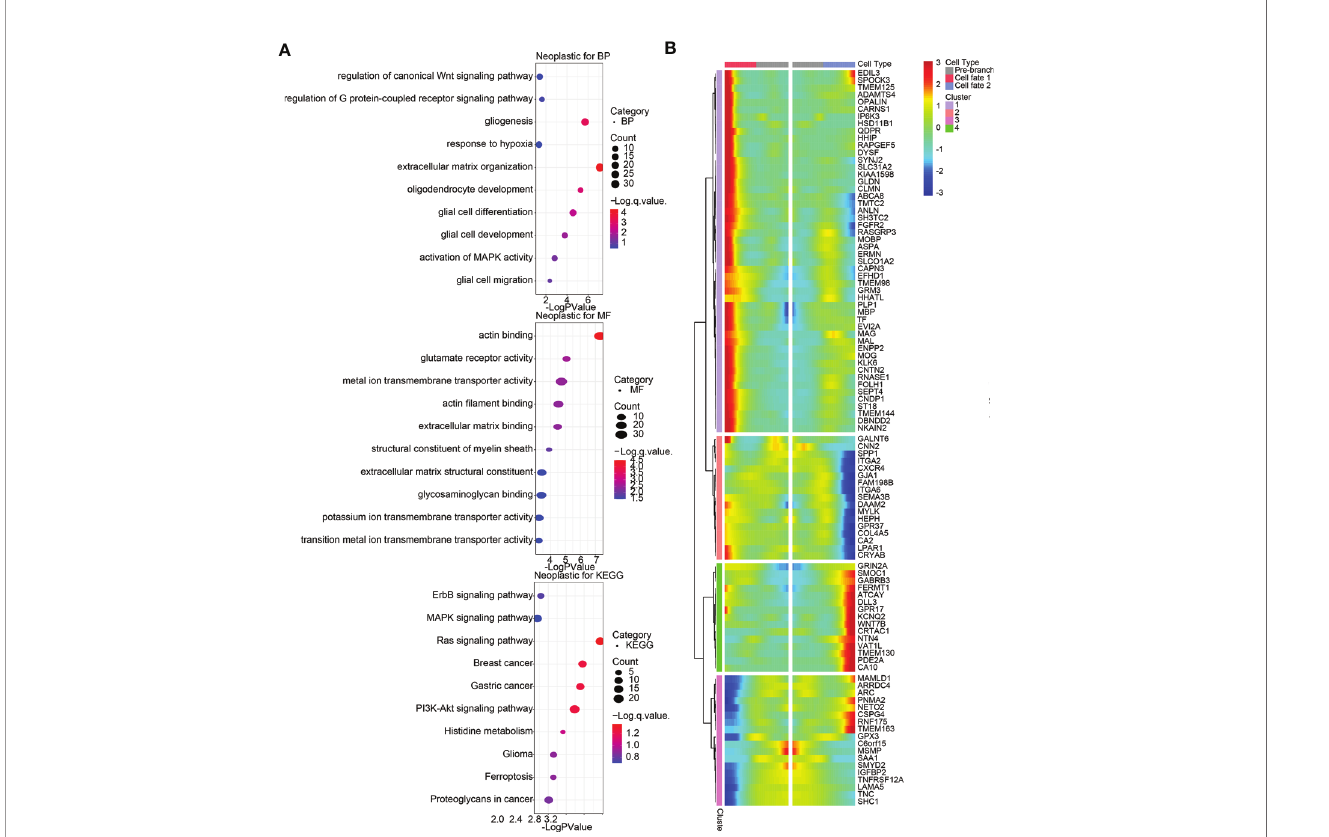
FIGURE 6 | Differentially expressed genes (DEGs) and functional annotations of glioma neoplastic cells in single-cell pseudotime trajectories. (A) Biological processes (BP) and molecular functions (MF) from Gene Oncology (GO) enrichment analysis and Kyoto Encyclopedia of Genes and Genomes (KEGG) pathway analysis based on DEGs for branch point 2 in neoplastic cells. (B) Heatmap of top 100 DEGs with branch-dependent expression for branch point 2 in neoplastic